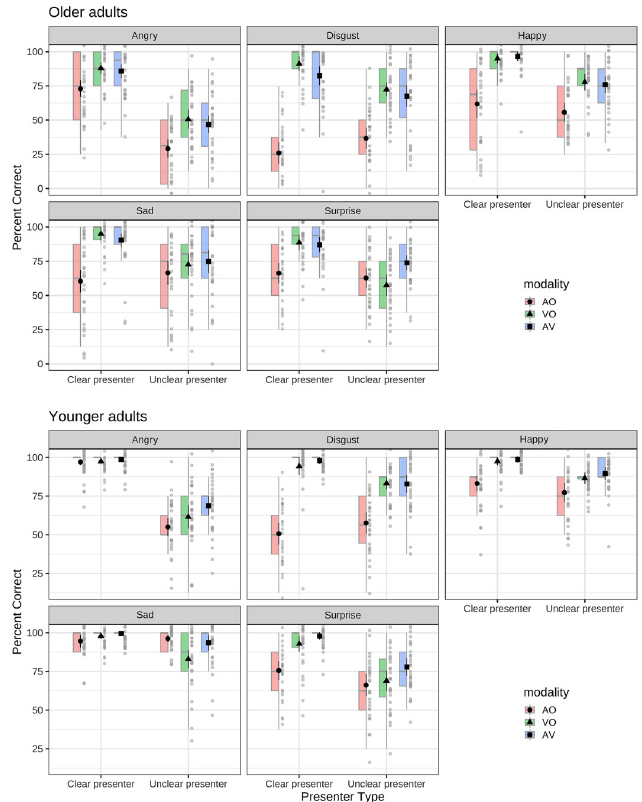
Fig 3. Box plots summarising the percent correct scores for older adults (top panel) and younger adults (lower panel) as a function of the clear and unclear presenter, presentation modality and emotion type. Filled symbols are the mean, horizontal bars the medium, box show the interquartile